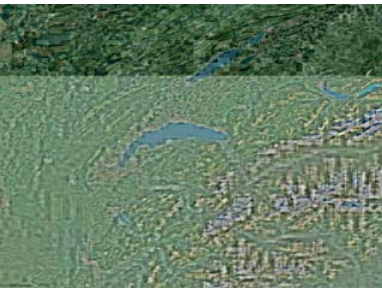
Fig. 2. The original image of the map of the area. If there are long fragments, then at them the correlation of spaces is higher, that is it fades at shift more slowly, so the possibility of restoration is more.